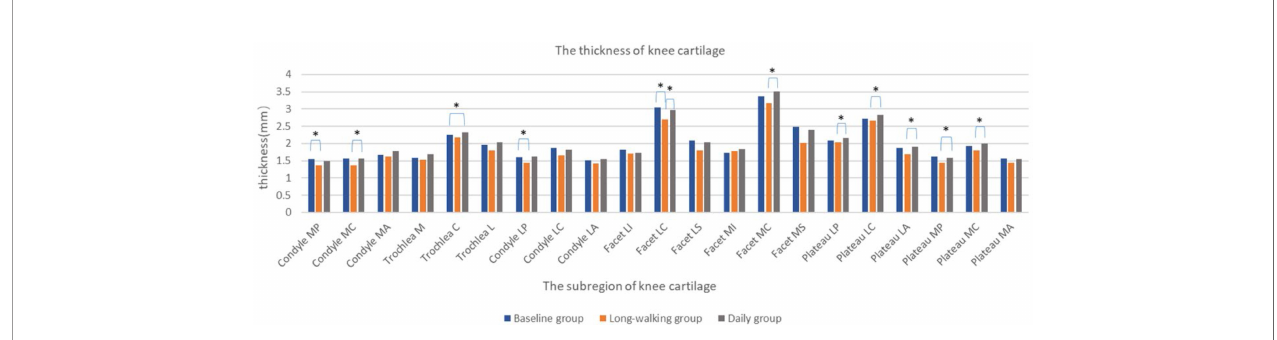
FIGURE 6 | Changes in the thickness of each sub-area of the knee cartilage in the three groups. * Indicates statistical signi